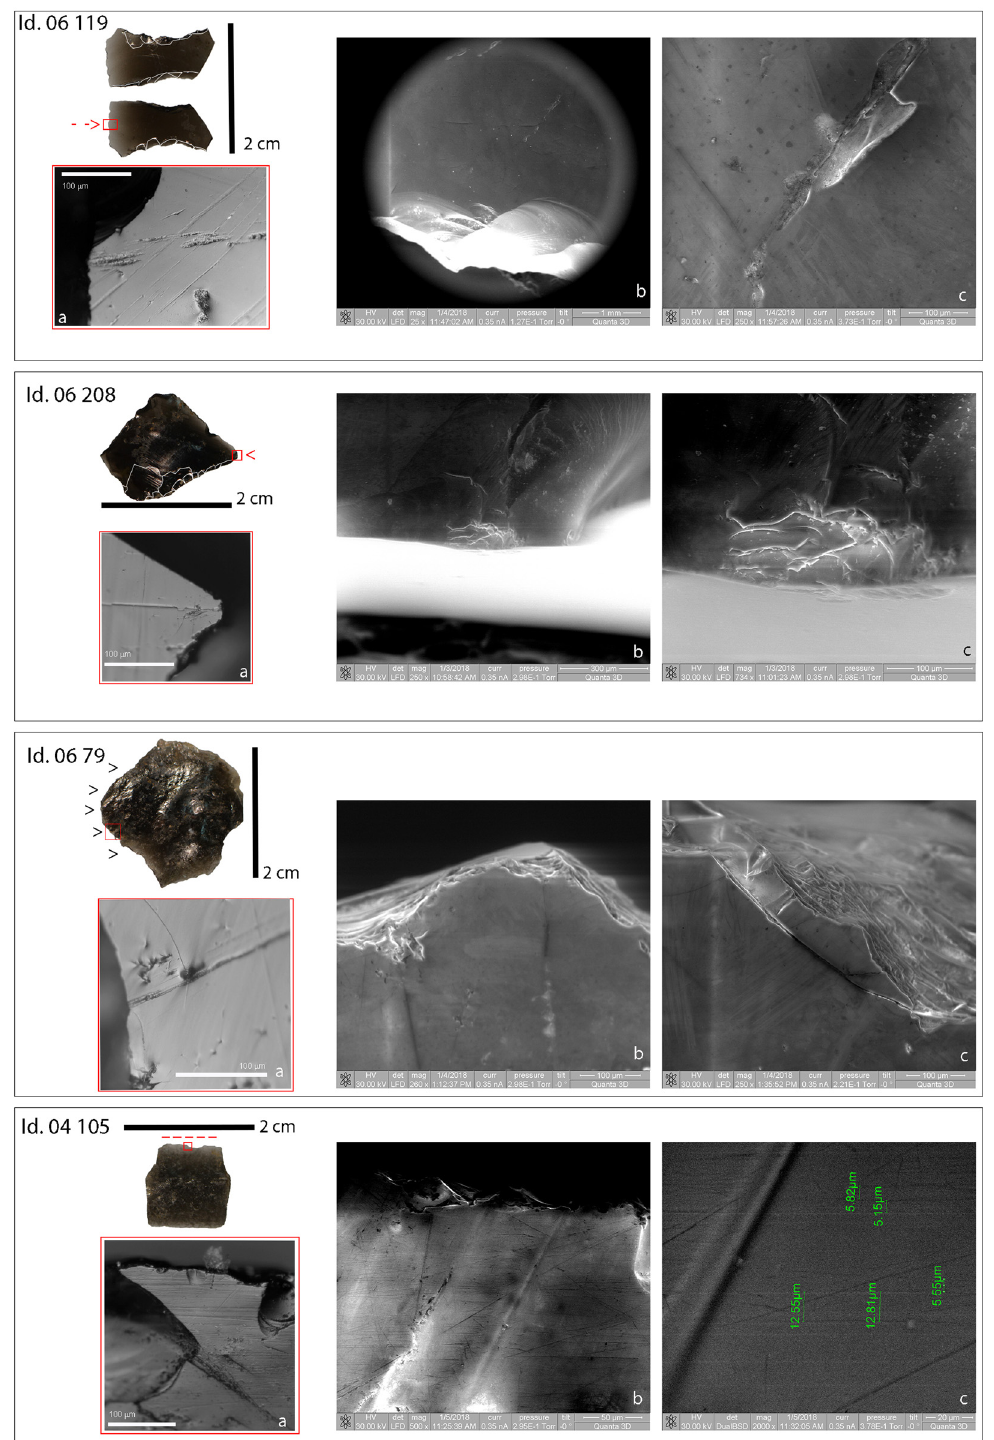
Figure 6: Obsidian tools from Neolithic layers. Id. 06 119, 06 208, 06 79, and 04 105: use - wear location on tools; use - wear ( scratches, incipient fractures, striae, abrasion ) observed with a re fl ected - light optical microscope ( OM 200 ×) ( a ) and by SEM ( b and c )